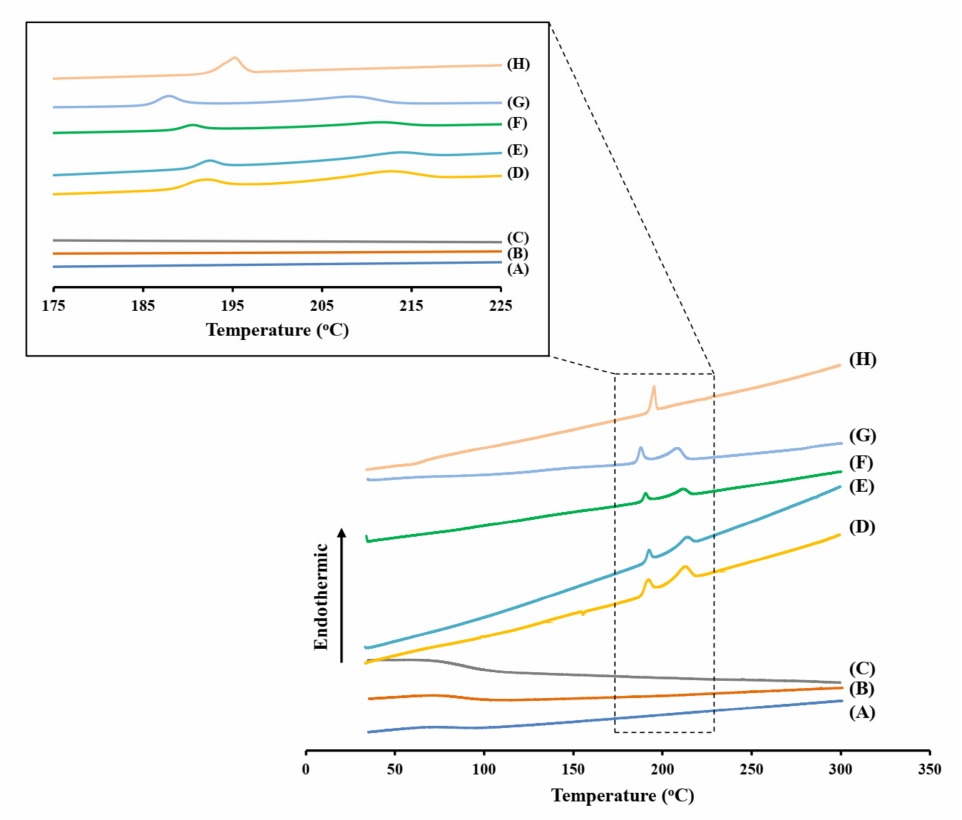
Figure 3. DSC thermograms of H-K4M ( A ), H-K15M ( B ) H-K100M ( C ), Tab-K4M ( D ), Tab-K15M ( E ), Tab-K100M ( F ) Tab-Mixed ( G ), and PNL ( H